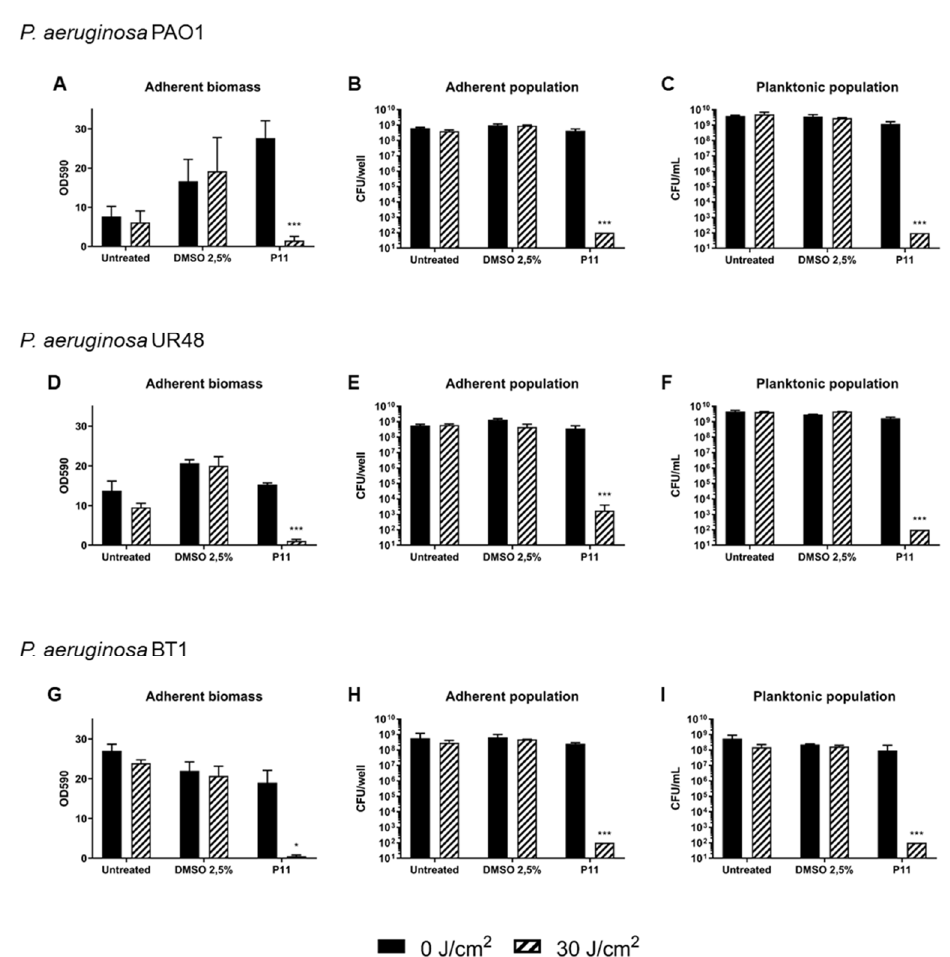
Figure 5. Inhibition of biofilm formation of P. aeruginosa PAO1 ( A – C ), UR48 ( D – F ) and BT1 ( G – I ) upon photodynamic treatment with diaryl-porphyrin P11. Overnight cultures of P. aeruginosa PAO1, UR48 and BT1 strains were diluted 500-fold in M9 minimal medium added with glucose (10 mM) and casamino acids (0.2% V / V ) reaching a concentration of ~10 7 CFU/mL and inoculated in 12-well microplate. P11 was added at a final concentration of 30 µ M and incubated in the dark for 1 h. Upon irradiation with a final dose of 30 J/cm 2 (100 mW/cm 2 , 300 s), bacteria were grown O/N at 37 ◦ C to form biofilm. The graphs report values of the optical density at 590 nm (OD 590) after biofilm staining with crystal violet ( A , D , G ), values of adherent population density (CFU/well) ( B , E , H ) and planktonic population concentration (CFU/mL) ( C , F , I ). Dark control samples are represented as black bars and light-treated samples as striped bars. Data represent the mean of at least three independent experiments ± the standard deviation. Statistical analyses were performed by one-way ANOVA (* p < 0.05; *** p < 0.0001).